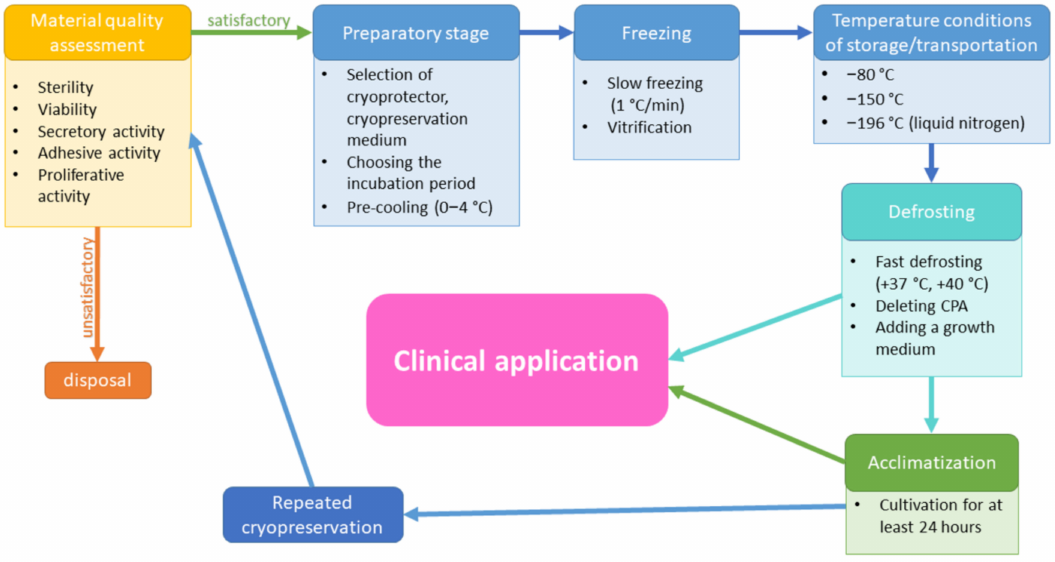
Figure 4. The main stages of a cryopreservation